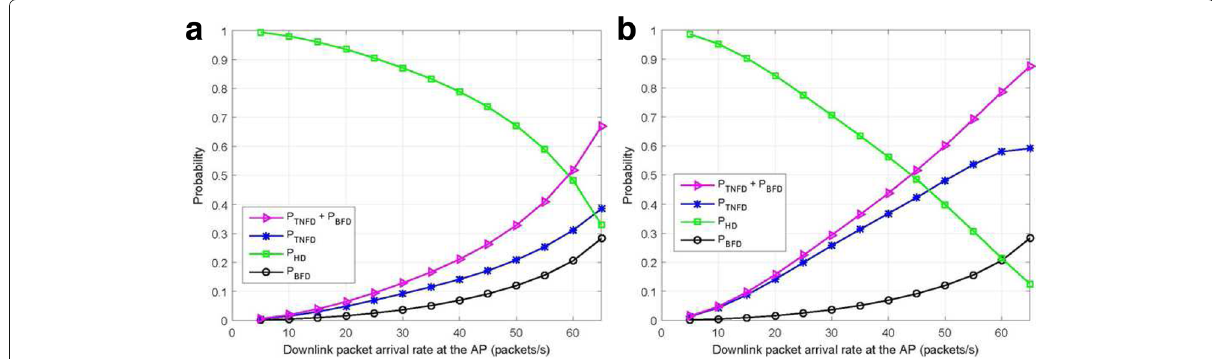
Fig. 9 Probability vs. downlink packet arrival rate at the AP. a Average HT ratio is 10%. b Average HT ratio is